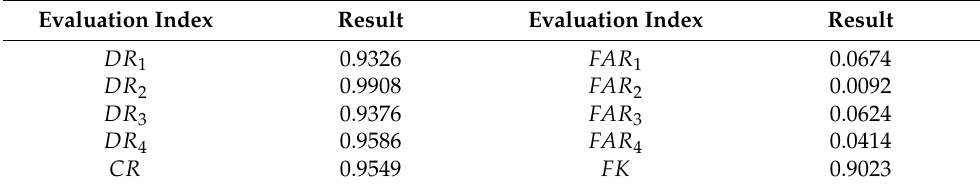
Table 4. The result of the evaluation index of the